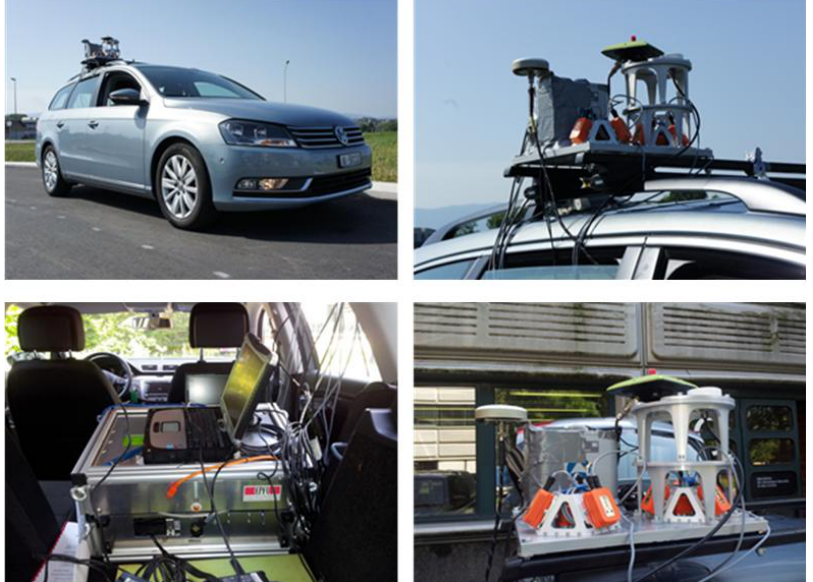
Figure 25 . Measurement platform mounted on the test